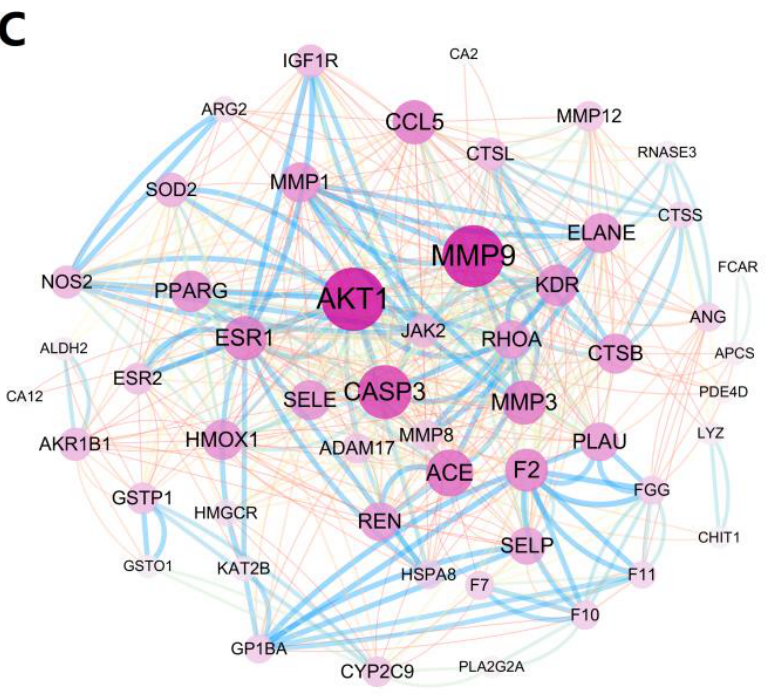
Figure 5. Graphs of ( A ) component–target network, ( B ) DO enrichment analysis and ( C ) PPI analysis.